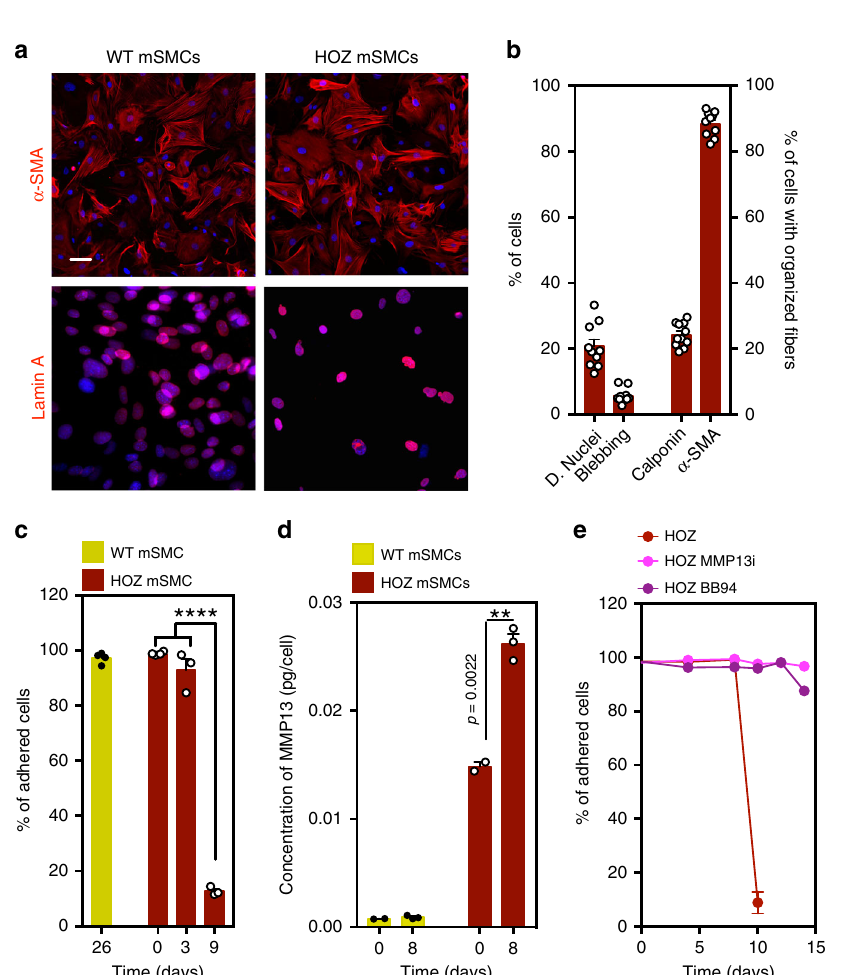
Fig. 3 Characterization and impact of fl ow shear stress in SMCs isolated from wild-type (WT) and homozygous (HOZ) Lmna G609G/G609G mice. a Mouse SMCs were cultured for 9 – 26 days in arterial fl ow conditions (120 dyne/cm 2 ). Immuno fl uorescence analyses performed on mouse SMCs (6-week- old WT and HOZ Lmna G609G/G609G mice) at passage 4 for α -SMA and Lamin A. Nuclei were stained with DAPI. Scale bar is 20 µ m. n = 3 – 4 images examined over three independent experiments. b Percentage of dysmorphic nuclei, nuclei blebbing, and SMC organized fi bers in mSMCs (assessed in static conditions). n = 3-4 images examined over three independent experiments. c Percentage of adhered cells over time. Cells were cultured under fl ow conditions. n = 3 – 4 independent experiments. Statistical analyses were performed by one-way ANOVA followed by Newman – Keuls ’ s post test. d Quanti fi cation of MMP13 in HOZ mSMCs and WT mSMCs. Cells were analyzed at day 0 and day 8 under fl ow. Fluorescence signal was normalized by cell number. n = 3 – 4 independent experiments. Statistical analyses were performed by a two-tailed unpaired Student ’ s t test. e Percentage of adhered cells over time. Cells were cultured under fl ow conditions. n = 5 – 6 independent experiments. In graphs b – e , results are mean ± SEM. *,**,***,**** denote statistical signi fi cance ( p < 0.05, p < 0.01, p < 0.001, p <